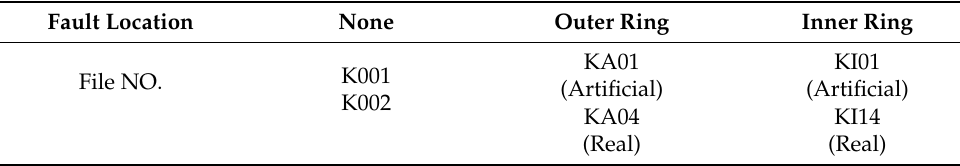
Table 8. Files of the PU bearing dataset used to construct the D,E,F